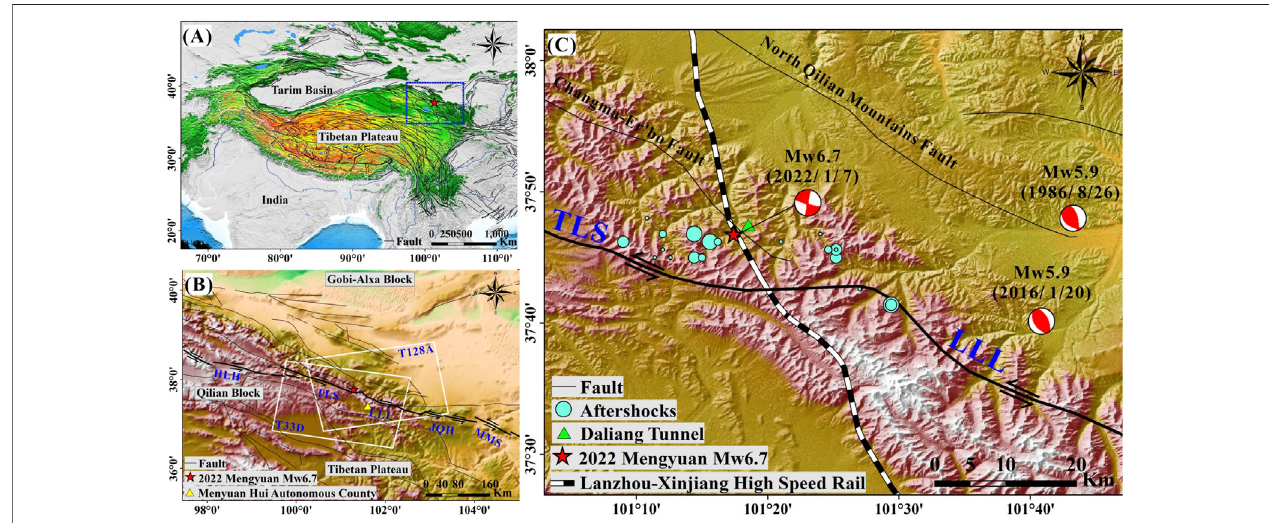
FIGURE 1 | (A) Faults (lines) on the TP (Deng et al., 2003). The blue rectangle represents the extent of (B). (B) Major faults in the study area. HLH: Hala Lake Fault. The white boxes are the image coverage area of the Sentinel-1A. (C) Focal mechanisms of 1986, 2016, and 2022 Menyuan earthquakes (data from the GCMT) and aftershock locations (blue dots). The Lanzhou-Xinjiang high-speed railway (LHSR) crosses the fracture zone.